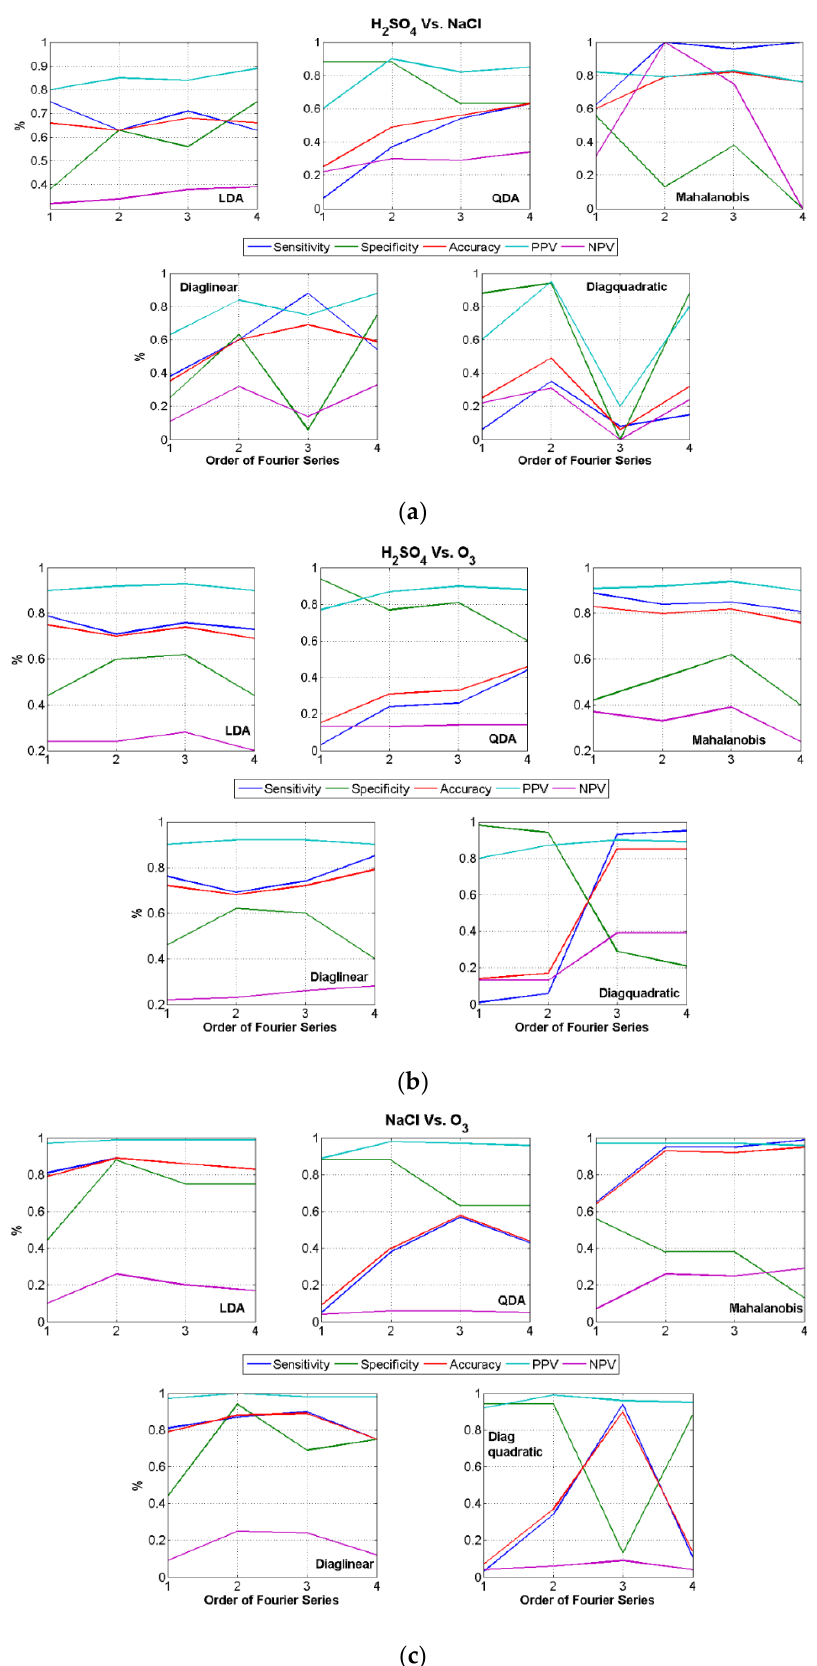
Figure 10. Binary classification results using Fourier Curve Fit Coefficients.